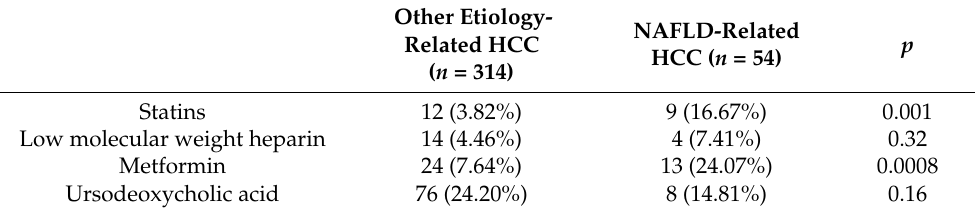
Table 3. Chronic medication of patients with HCC unrelated to oncologic treatment.